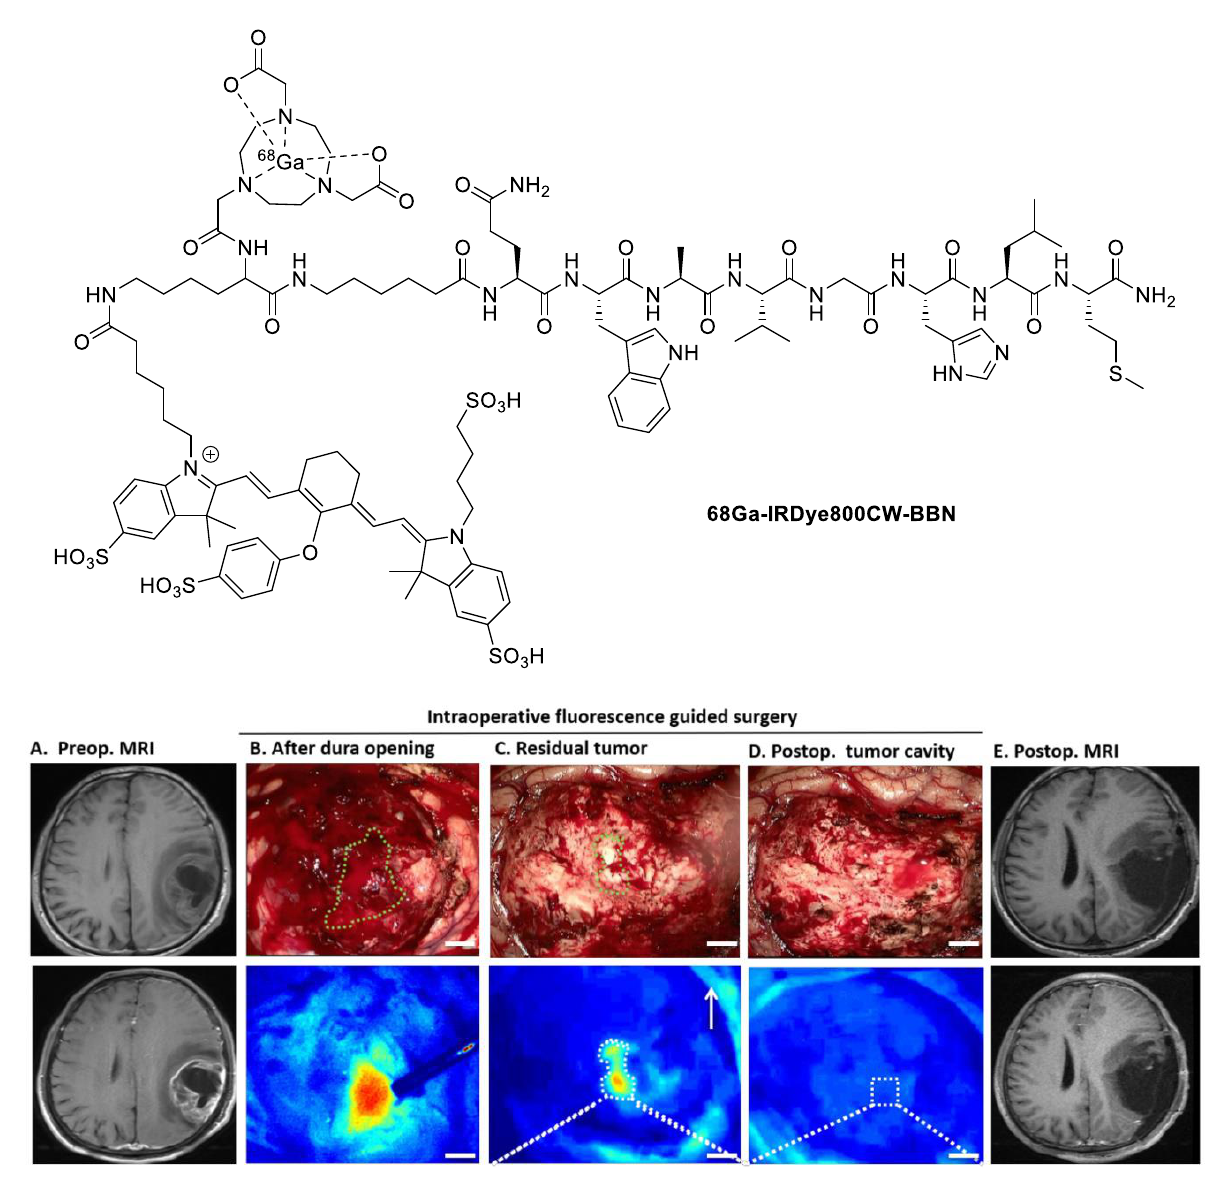
Figure 5. Structure of 68 Ga-IRDye800CW-BBN ( top ). NIRF image-guided glioblastoma resection using 68 Ga-IRDye800CW-BBN ( bottom: Reprinted from Ref. [42]. 2018, Theranostics). The fluorescent tumor is delineated by green dashed lines in the white-light images.